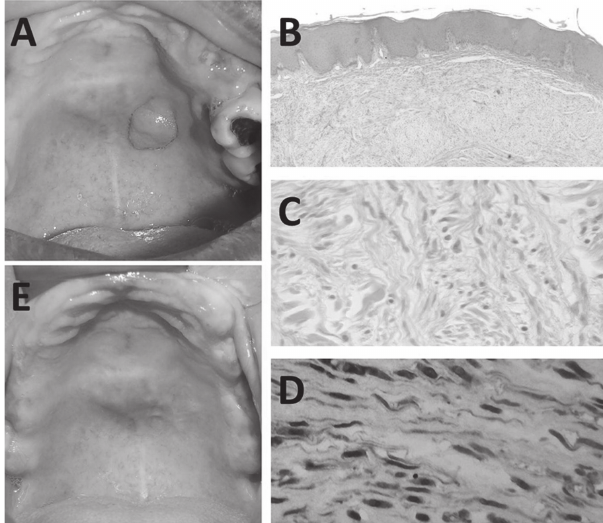
Figure 1 Solitary neurofibroma of the palate. A, Initial clinical aspect of the lesion. B, Photomicrograph showing the presen - ce of a nonencapsulated benign tumor, consisting of fusiform cells with undulated nucleus. C, Photomicrograph showing spindle cell proliferation amid a myxomatous stroma, at times microvacuolated (HE, 100×). D, Strong immunohistochemical staining of spindle cells for S-100 protein (200×). E, Extra-oral examination after six months, showing complete